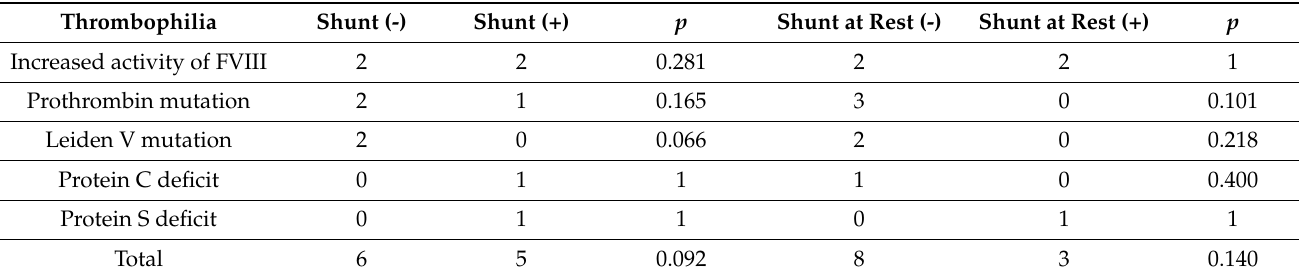
Table 3. Relation of contrast-enhanced transcranial Doppler ultrasound results with inherited venous